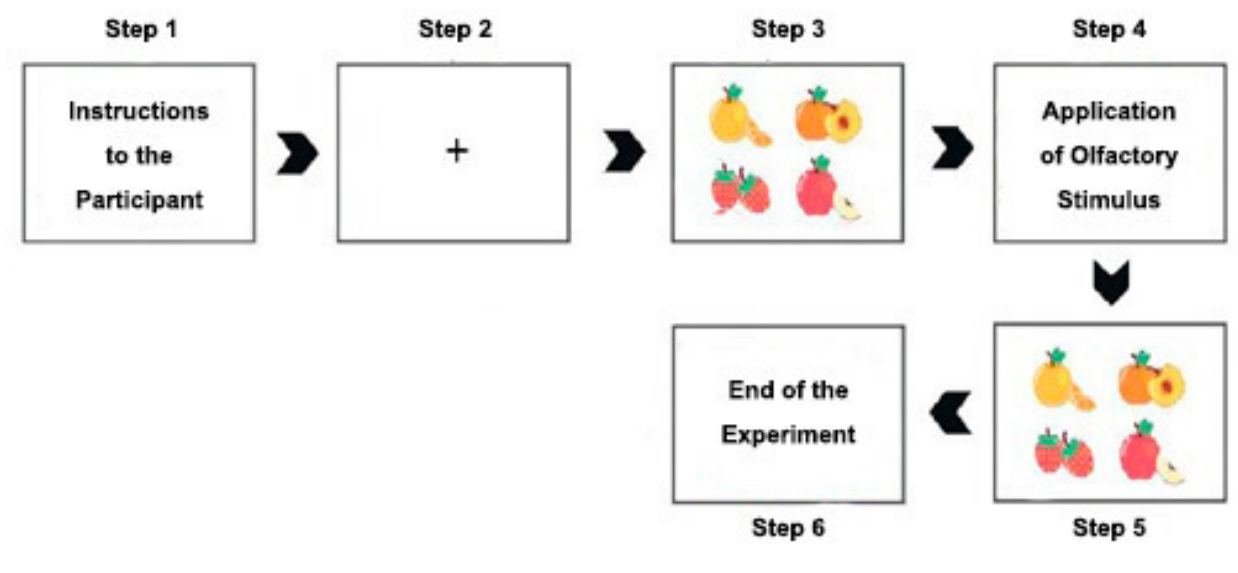
FIGURE 3 – Scheme of the experimental with images.